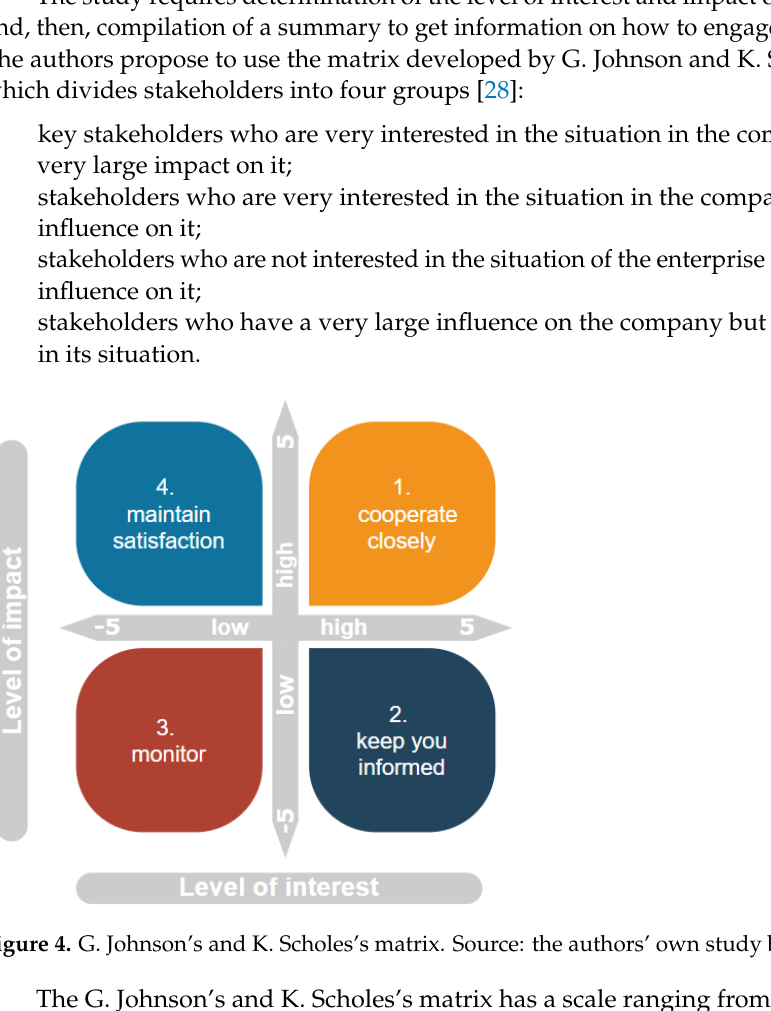
Table 1. The proposed header part of the tool .